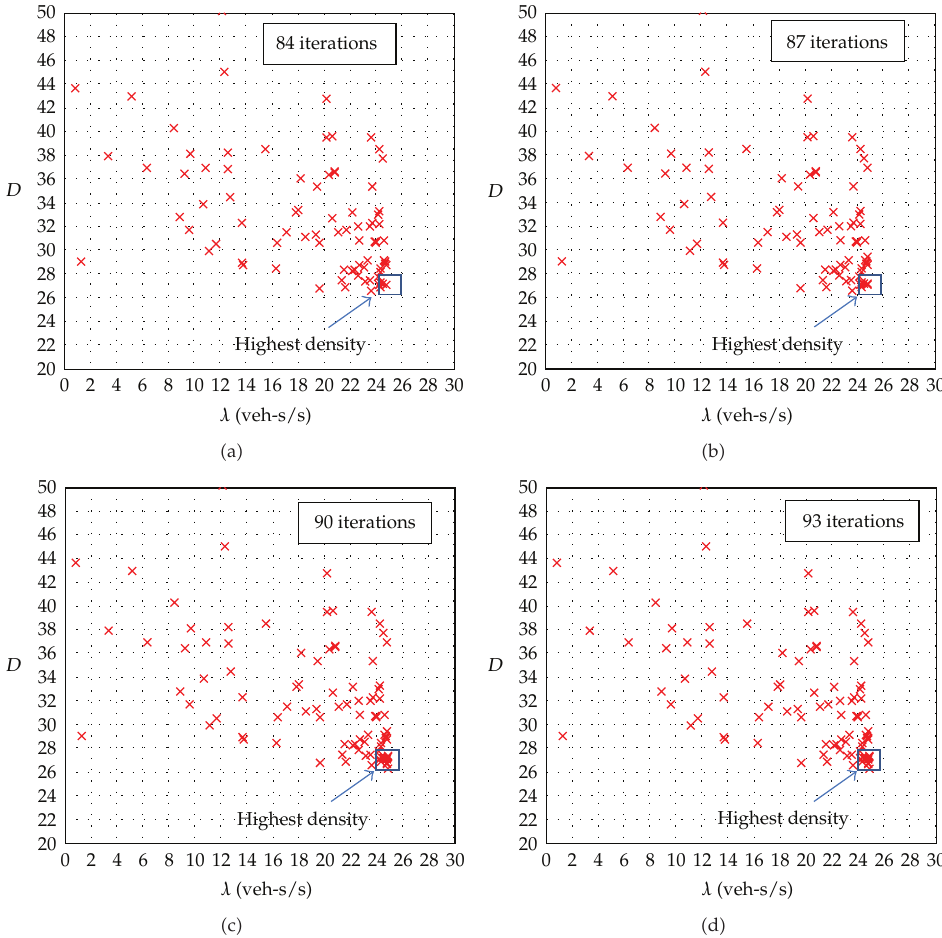
Figure 2: Two-dimensional plot of the convergence